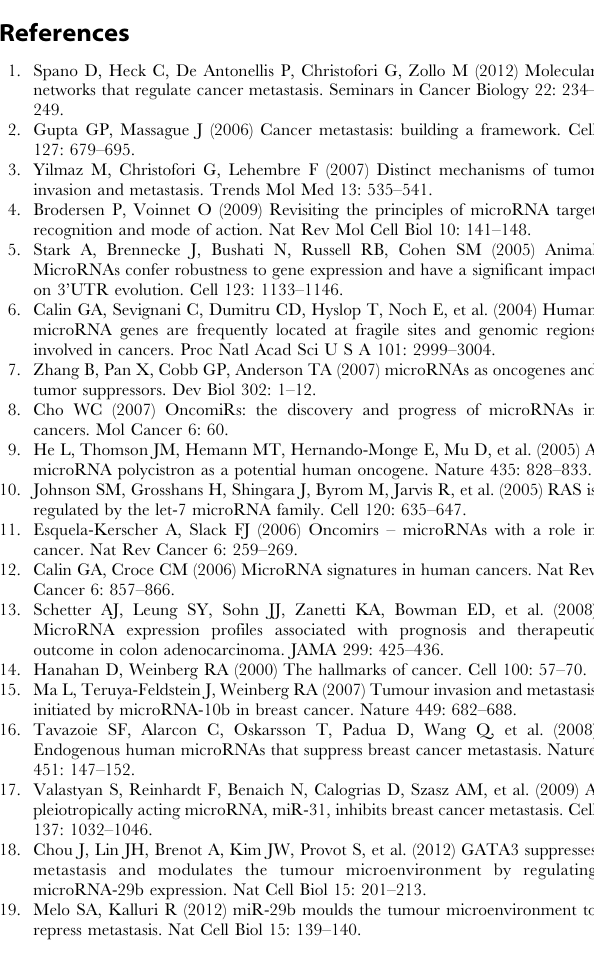
Figure S3 siRNA mediated MMP-2 knock/down in HCT116 cells. HCT116 cells were transfected with MMP-2 trilencer 27-human siRNA (0.1 nM to 10 nM). 48 h after transfection, cells were harvested and MMP-2 protein was analyzed by western blot. 5 nM MMP-2 siRNA showed maximum efficacy in silencing MMP-2. Figure S4 Hexane fraction of American Ginseng (HAG) suppresses MMP-2 activity. HCT-116 cells were treated with 260 m g/ml of HAG for 0 and 24 h. Cells were harvested and MMP-2 activity was accessed by western blot analysis. HAG suppressed the pro- and active-MMP2